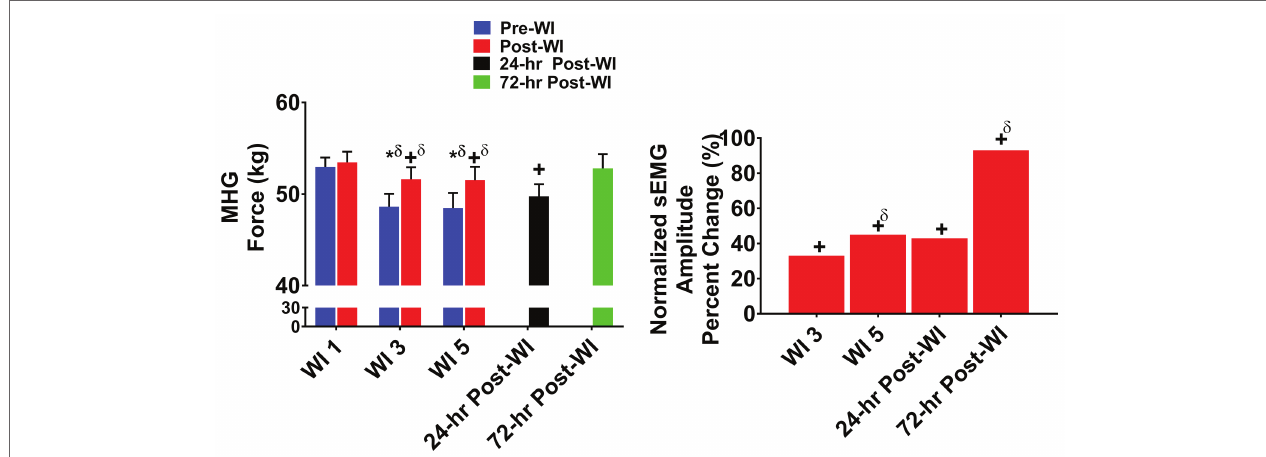
FIGURE 2 | Maximum handgrip (MHG) results. Across subject ( n = 13) mean ± SEM is shown. Left graph – performance (force): post-WI MHG performance was greater when compared to pre-WI. Additionally, performance declined on WI 3 and 5 when compared to WI 1. Performance for both groups returned to baseline performance by 72-h post-WI. “*” denotes pre/post-WI main effect ( p < 0.05). “+” only denotes time main effect ( p < 0.05). Main effect symbol with “ δ ” denotes ( p < 0.001). Right graph – normalized sEMG day percent change: brachioradialis neuromuscular activation increased each day when compared to WI 1. “+” denotes time main effect ( p < 0.05). Main effect symbol with “ δ ” denotes ( p <